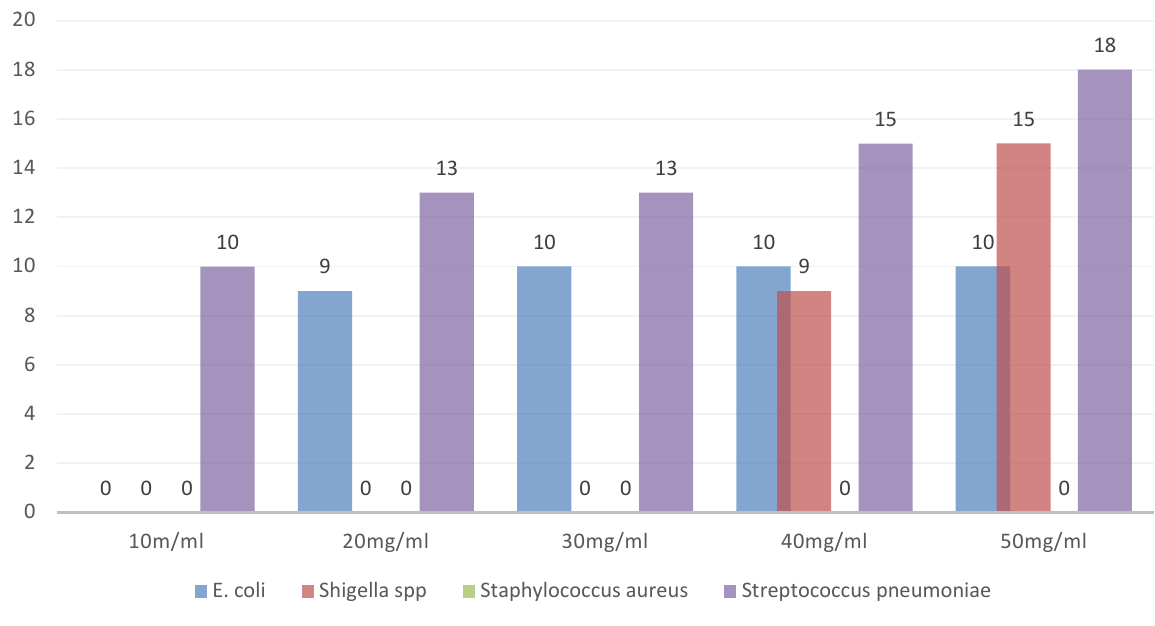
Table 6. The minimum inhibitory concentration of